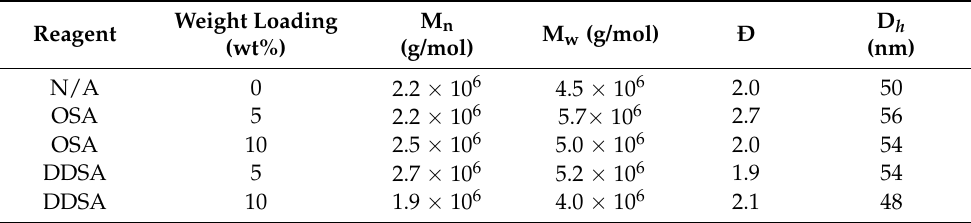
Table 1. Absolute molecular weight averages determined by GPC analysis of starch modified in the dispersed phase with OSA and DDSA. Weight Reagent